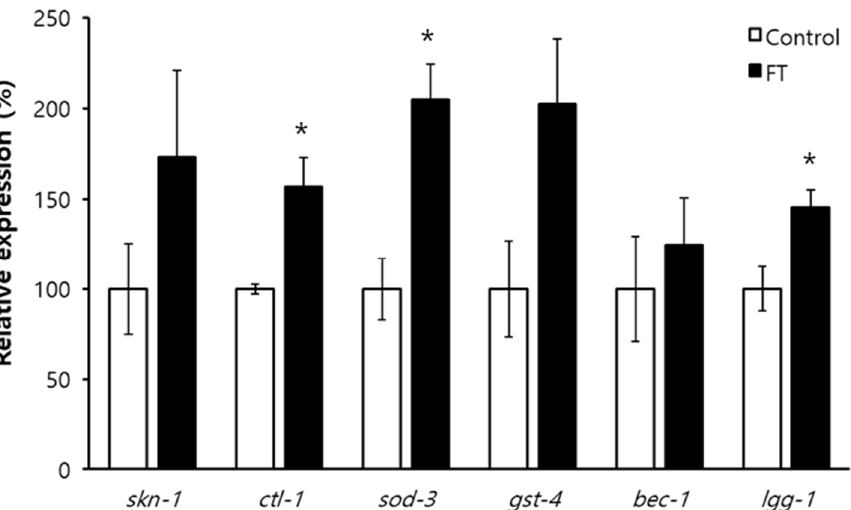
Figure 6. Quantitative RT-PCR of genes modulating anti-oxidant response and autophagy. Total RNA was extracted from 9-day-old worms and used for quantitative RT-PCR. Relative percent expression of each gene in fisetin-treated worms was calculated comparing to the expression of the same gene in untreated control (100%). Error bar indicates standard error. *, p < 0.05 compared with control; FT, 0.1 g/L of fisetin.